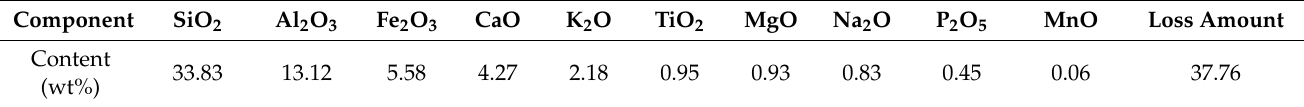
Table 1. Chemical composition of fly ash used in this